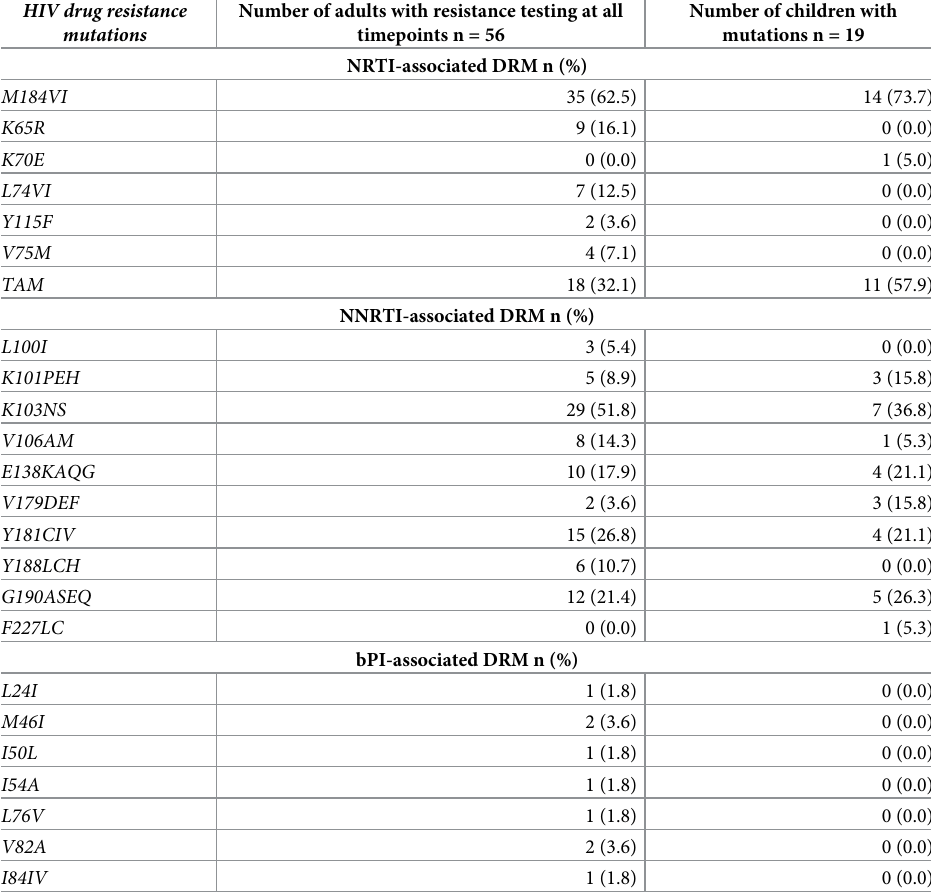
Table 3. Drug resistance mutations in patients with virologic failure. HIV drug resistance